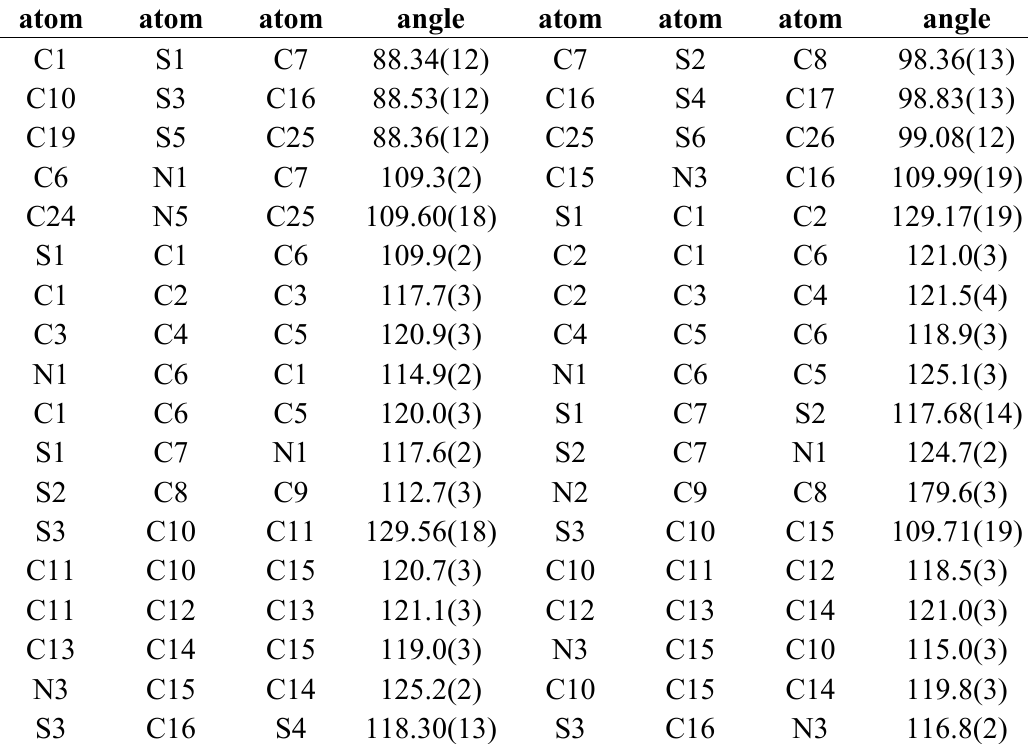
Table 2. Bond angles (o) for compound 2